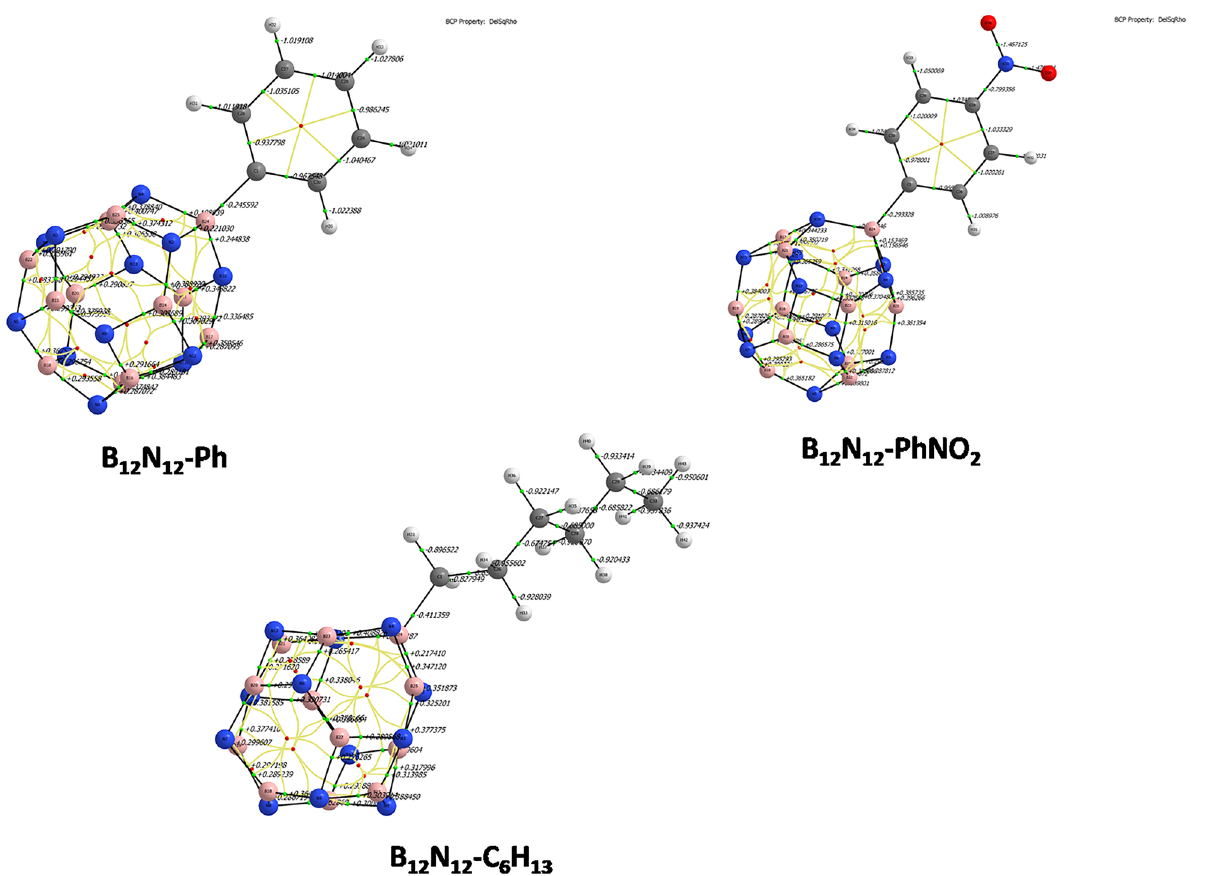
Figure 7. Molecular graph of the grafted B 12 N 12 structures (the lines are bond paths).